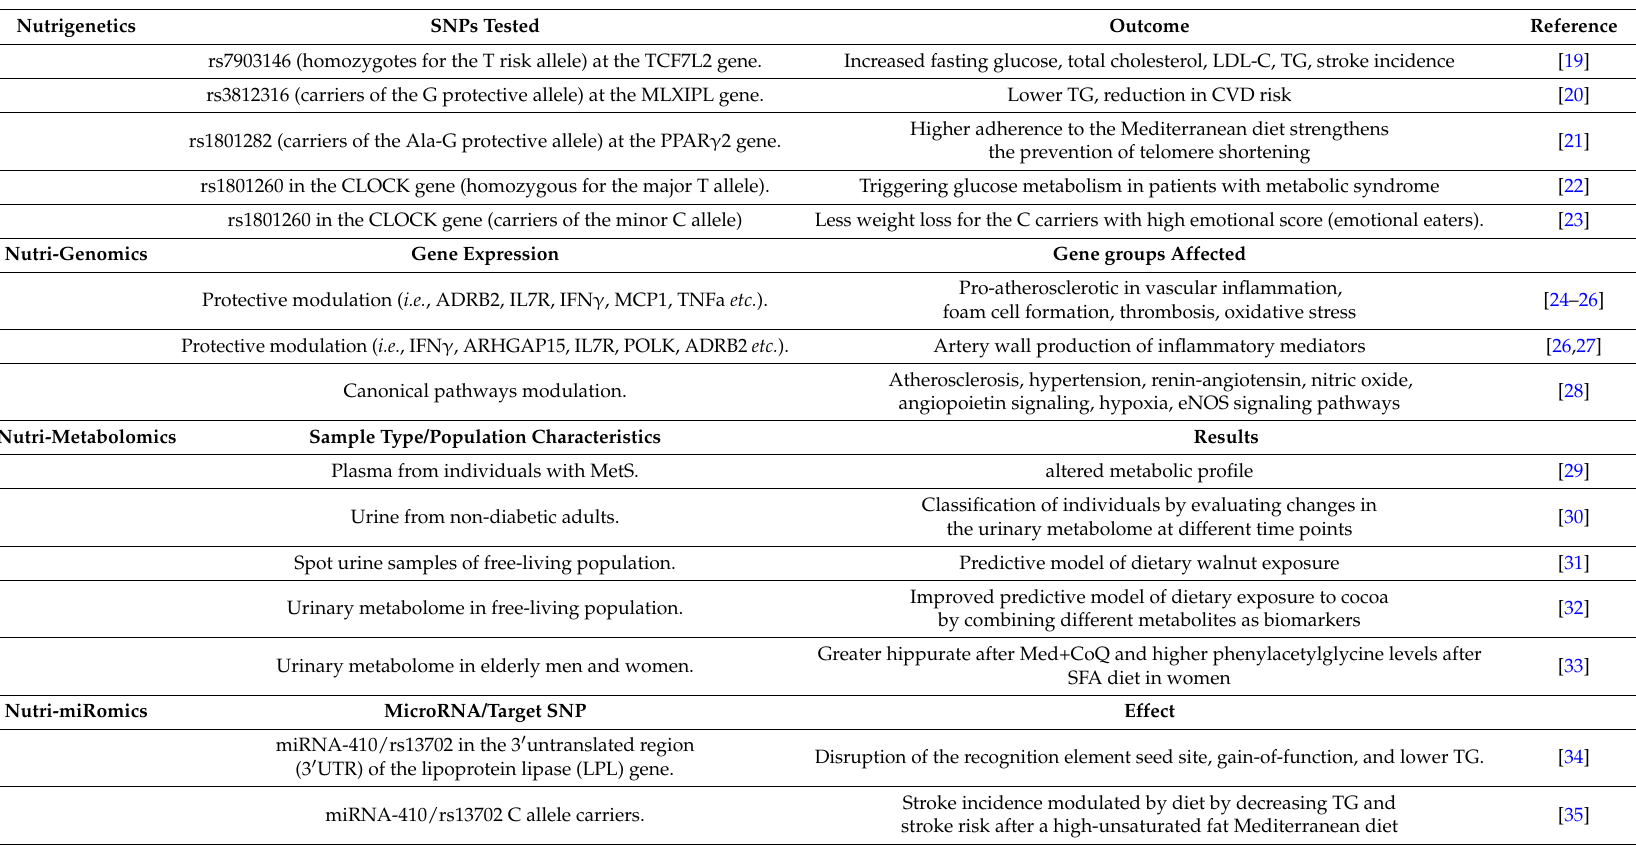
Table 1. Nutrigenetics, nutrigenomics, nutri-metabolomics, and nutri-miRomics studies related to Mediterranean diet interventions in humans.